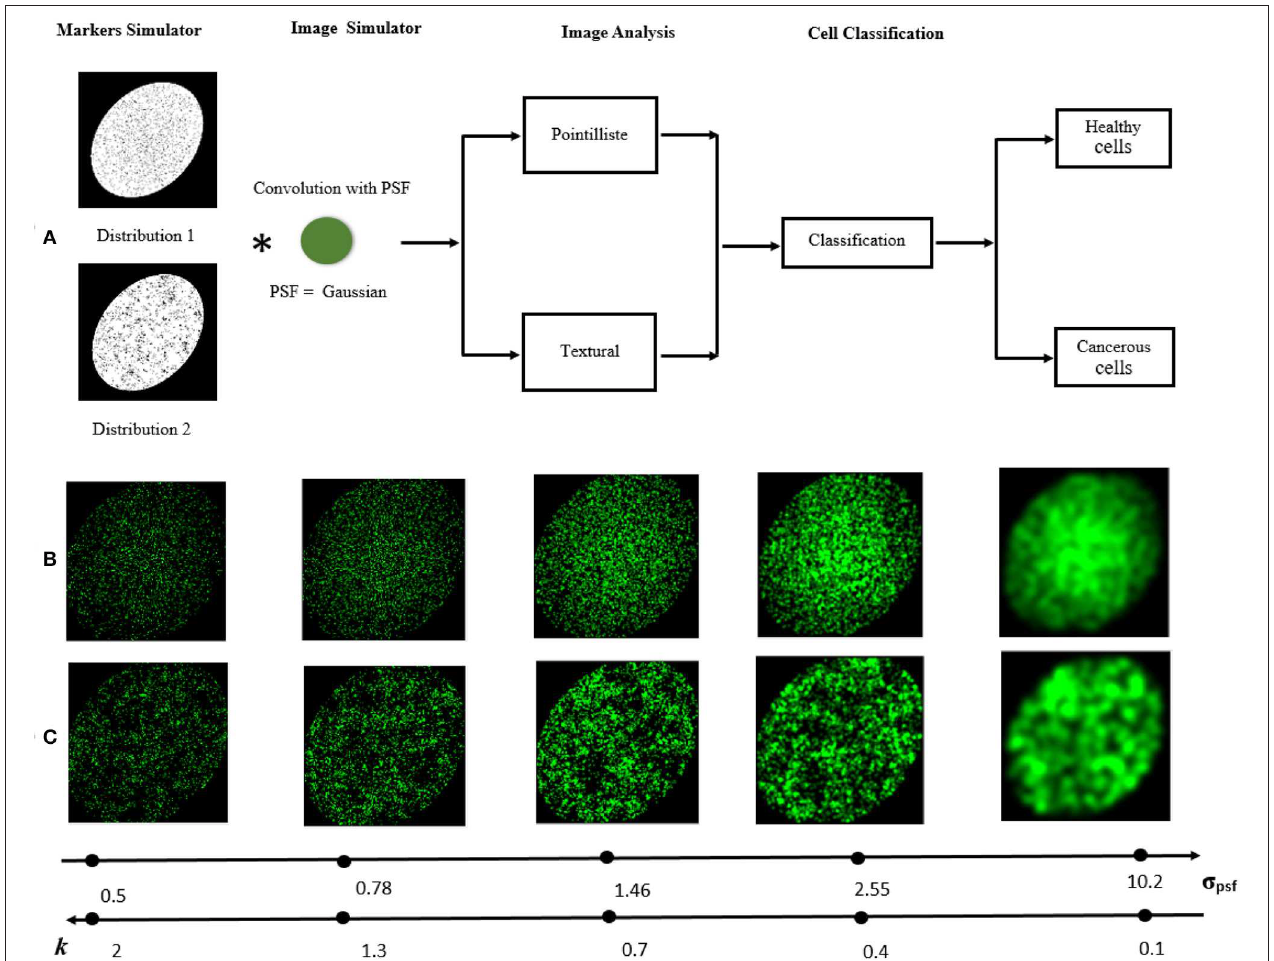
FIGURE 3 | Visual abstract. (A) The processing pipeline to simulate cell and classify them with distinct fluorescent marker densities or organizations. The image acquired by the microscope is simulated by the convolution of the distribution of markers with the PSF. To classify the cell types, two approaches are studied for different values of PSF: pointillist and textural. (B,C) Examples of synthetic microscopic images [( C 1 ) or ( C 2 ) in (B) and ( C 3 ) in (C) ] for different values of σ psf and the corresponding k ratio according to Equation